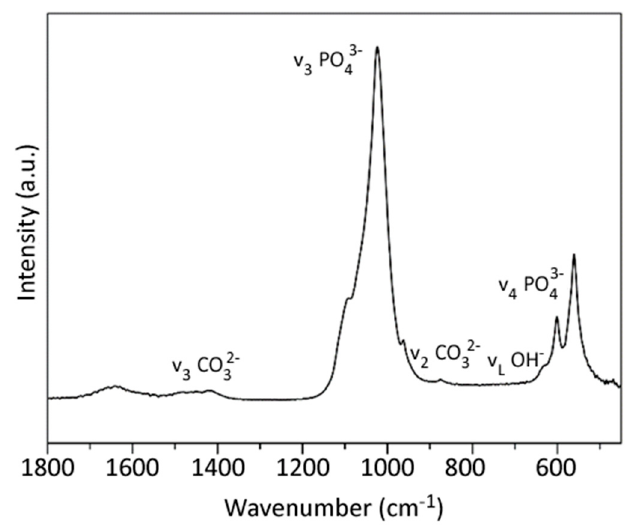
Figure 4 . Fourier transform infrared (FT-IR) spectra of n HA in the region from 1800 cm − 1 to 400 cm − 1 .